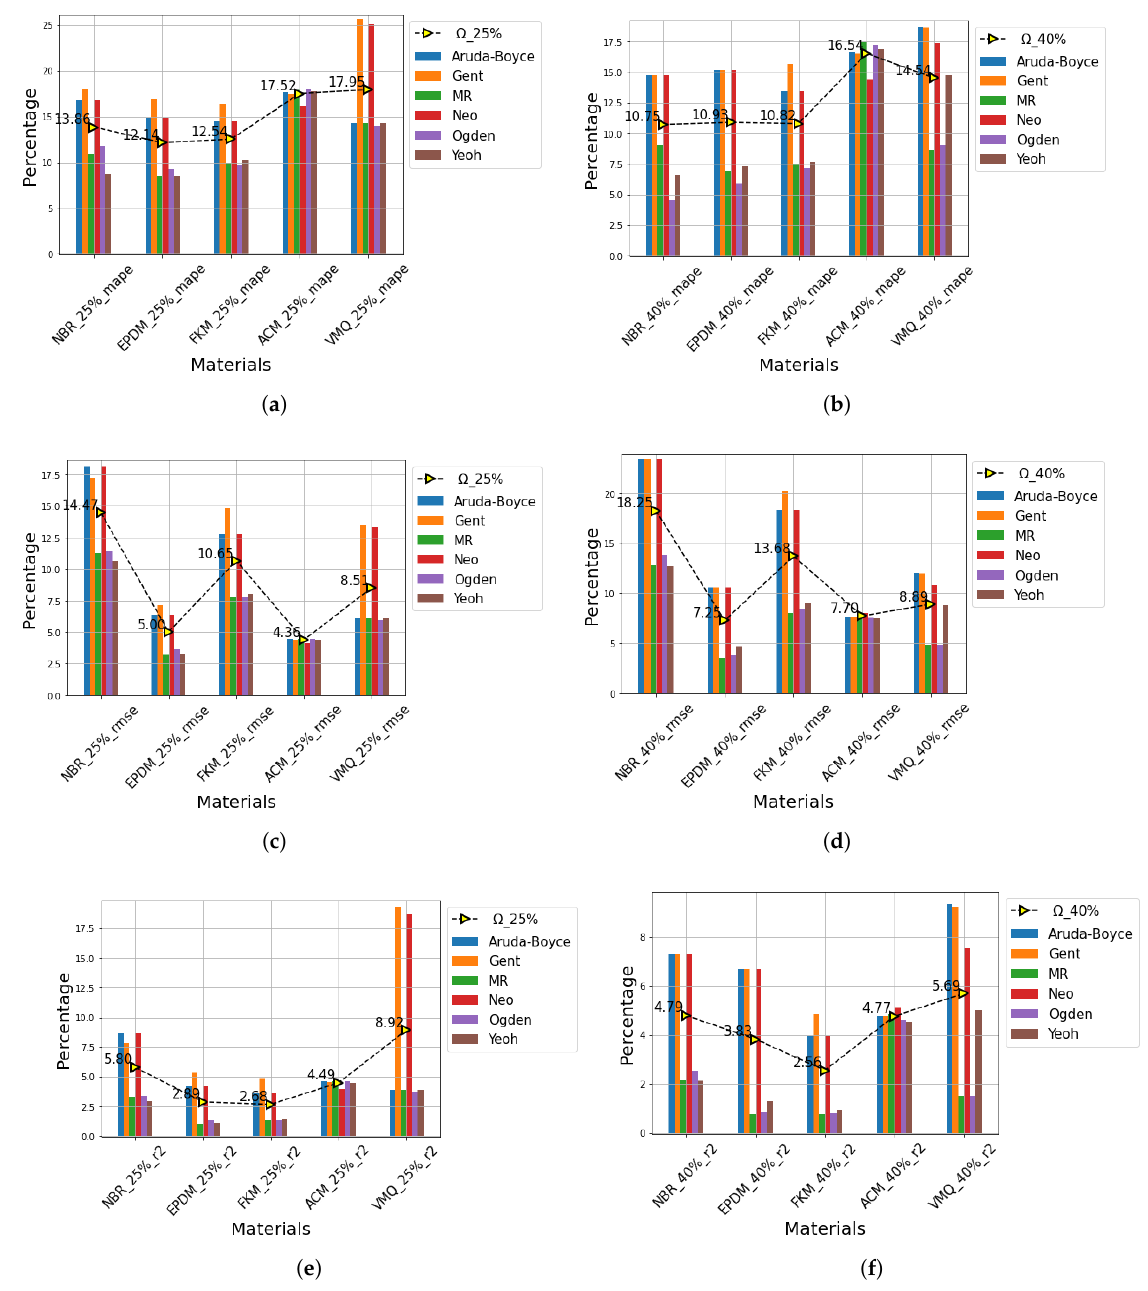
Figure 9. Curve similarity assessment of hyperelastic models per RLM ( a ) MAPE at 25% displacement, ( b ) MAPE at 40% displacement, ( c ) RMSE at 25% displacement, ( d ) RMSE at 40% displacement, ( e ) R2 at 25% displacement, and ( f ) R2 at 40%